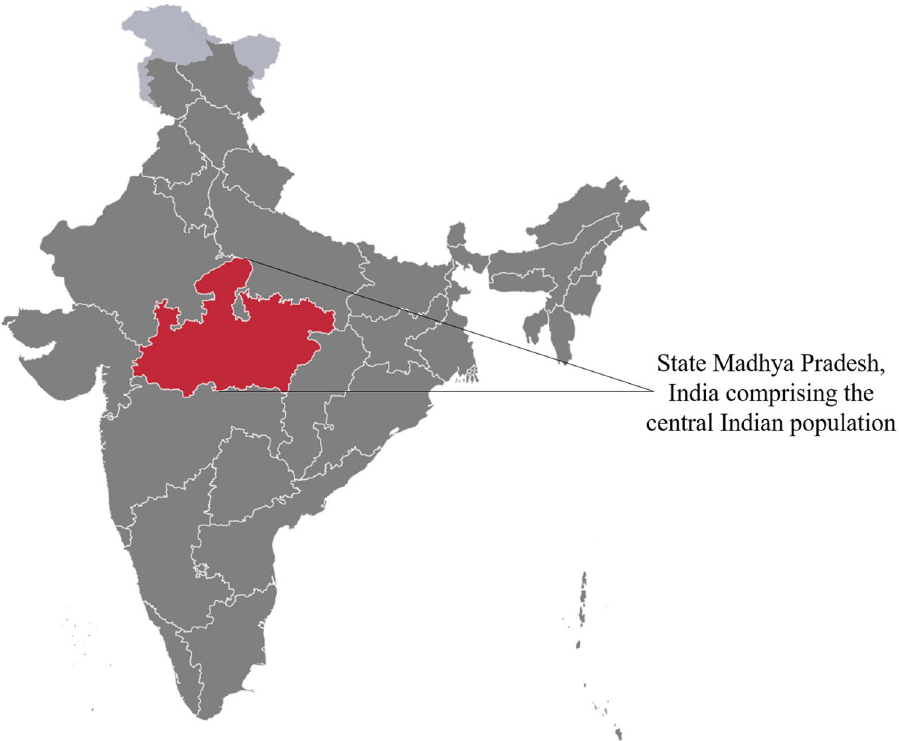
Figure 1. Map of India highlighting the central Indian population residing in the state Madhya Pradesh, India (https:// en. wikip edia. org/ wiki/ Madhya_ Prade sh#/ media/ File: IN- MP.